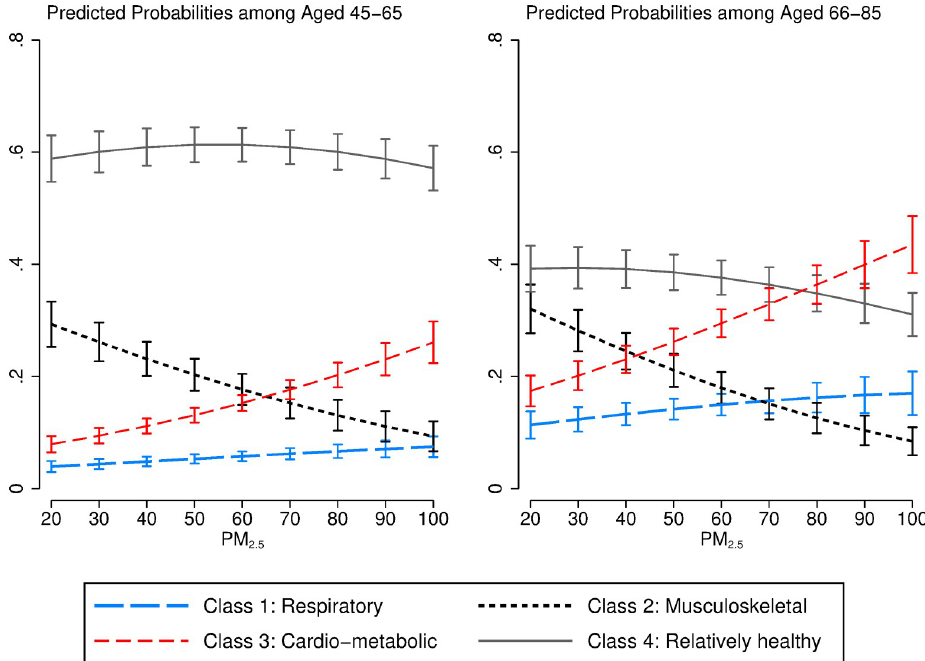
Fig 2. Predicted probabilities of 11-year PM 2.5 exposure on latent multimorbidity patterns by age groups. Note: Models adjusted for age, age squared, gender, education, HuKou-residence, occupations, marital status, smoking status and logged